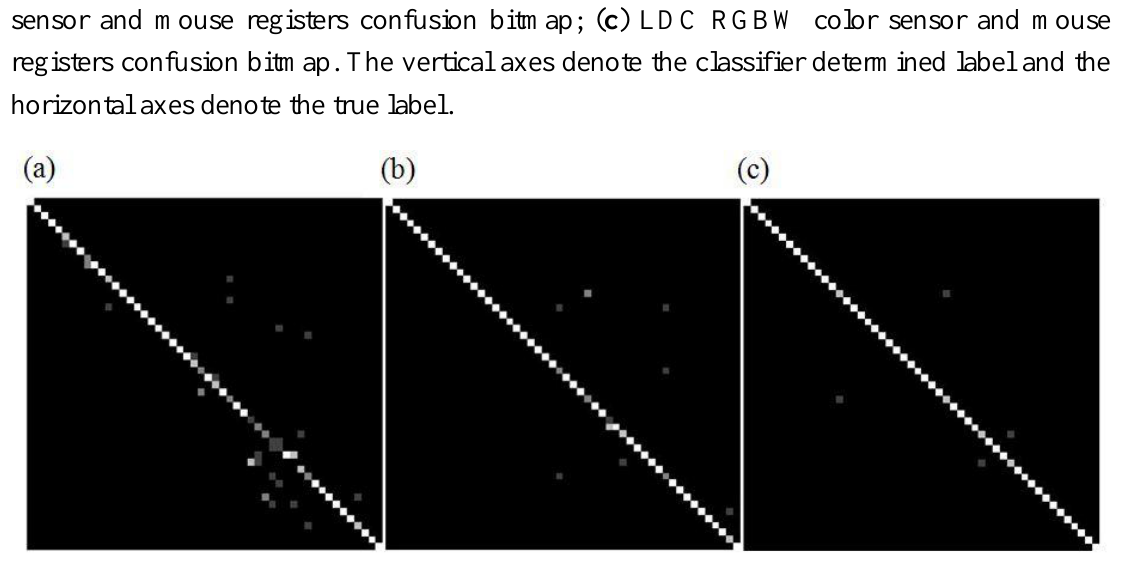
Figure 4. ( a ) LDC webcam color and texture confusion bitmap; ( b ) LDC RGB